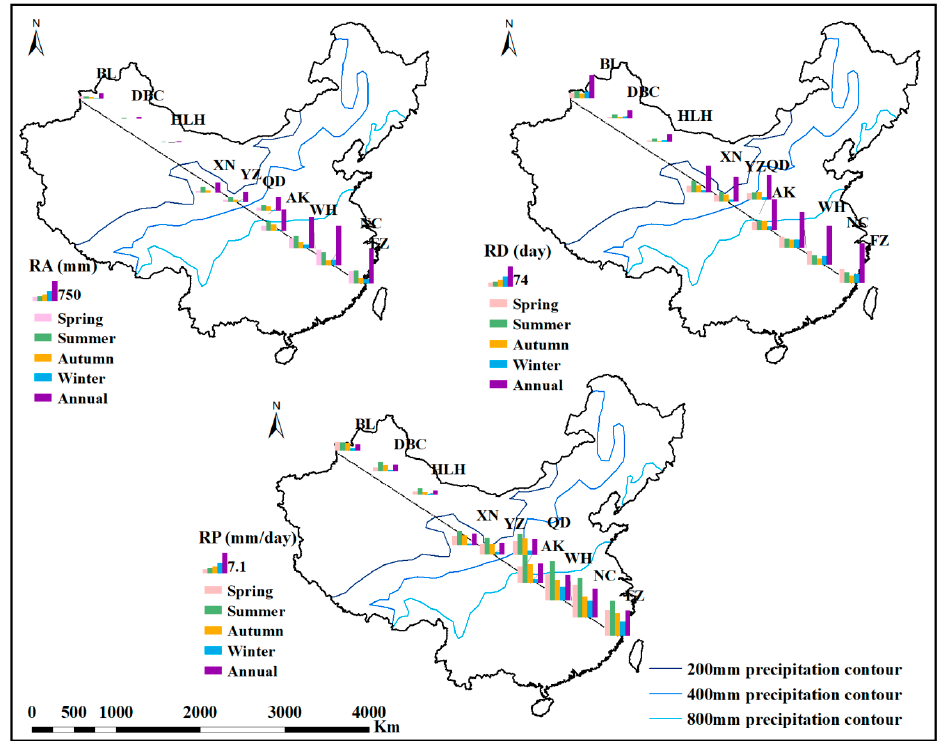
Figure 7. Spatial changes of precipitation indices with distance from the sea. Precipitation indices included rainfall amount (RA), rainfall days (RD), and daily precipitation on rainy days (RP).